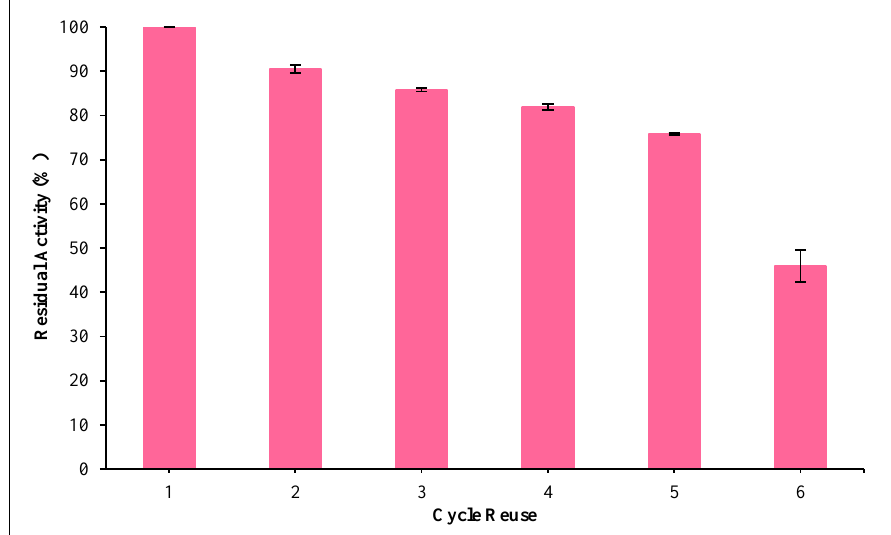
Figure 8. Residual activities of the immobilized enzyme (mean ± SD; n = 2; p < 0.05) for six subsequent uses. Assuming the initial enzyme activity was 100%